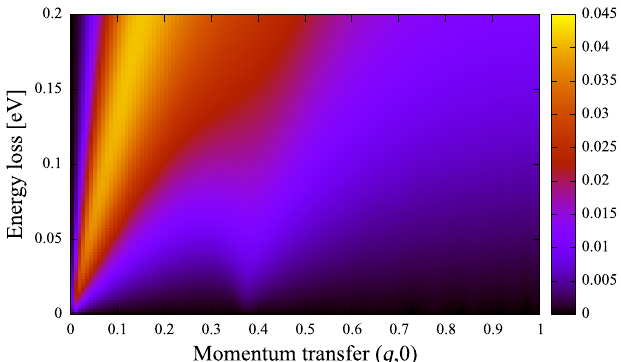
FIG. 3. Bare contribution to RIXS from particle-hole scattering. Momentum transfer is given in units of π =a